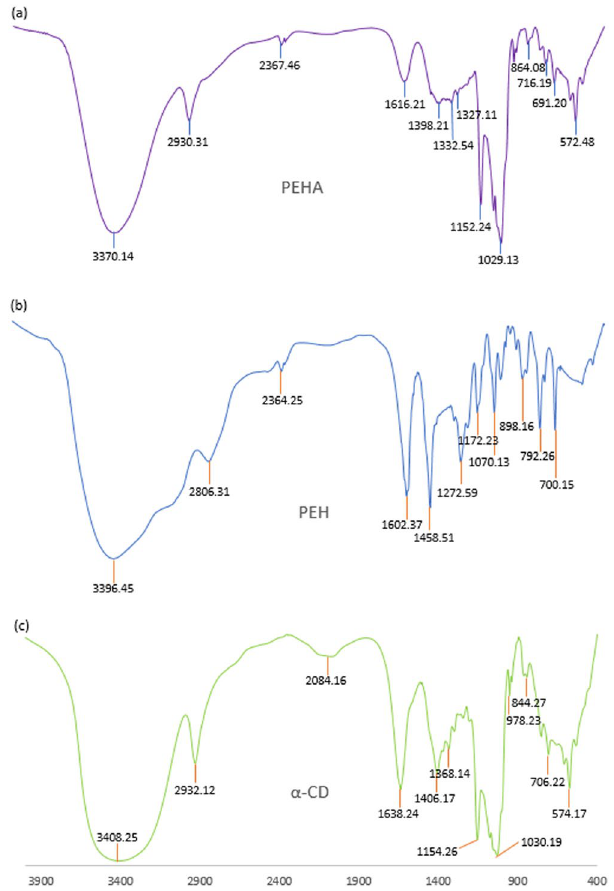
Figure 15. (a , b , c) FTIR spectra of (a) PEH + α -CD, (b) PEH, (c) α